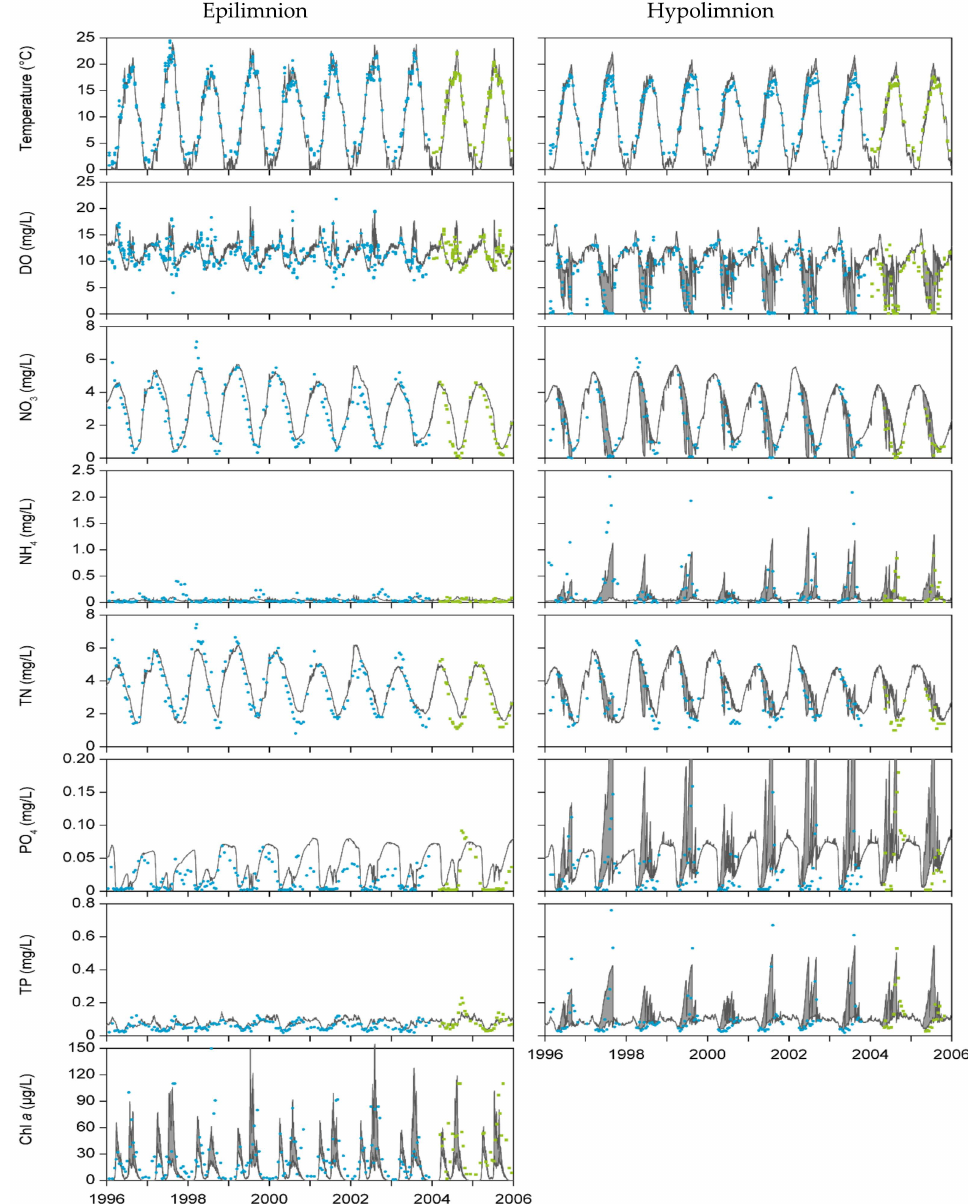
Figure 2. Comparison of model simulation results (line) against observations (dots) during the calibration (blue circles) and the validation periods (green squares) in the epilimnion (0.0– − 3.0 m) and the hypolimnion ( − 6.0– − 10.0 m), respectively. A, temperature. B, DO. C, nitrate. D, ammonium. E, total nitrogen. F, phosphate. G, total phosphorus. H, Chl